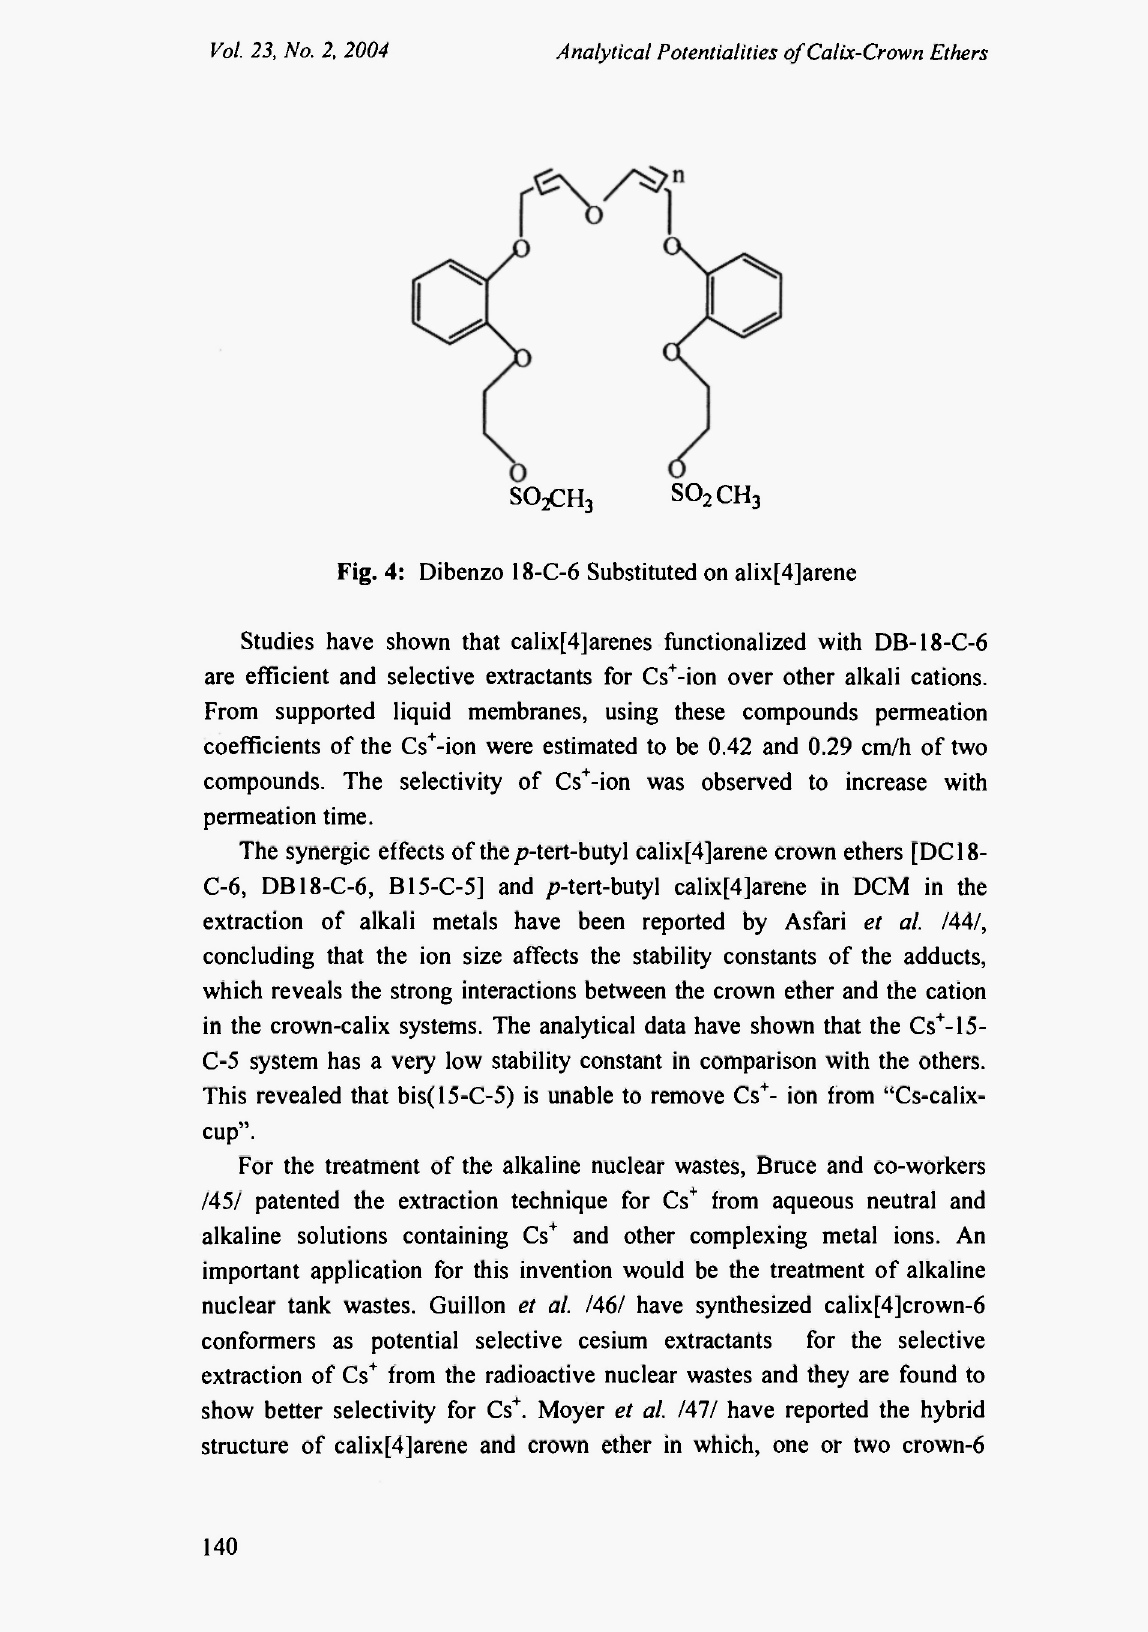
Fig. 4: Dibenzo 18-C-6 Substituted on